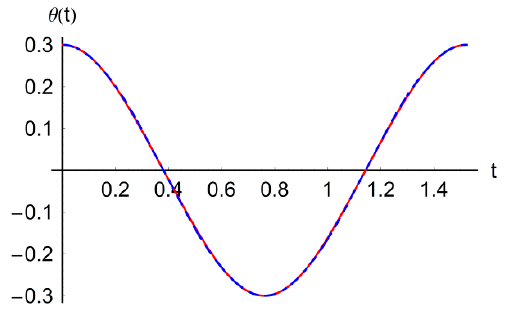
Figure 20. Comparison between the approximate solution (50) and numerical integration results for A = 0.4, L = 0.6. _____ numerical_ _ _ _approximate solution.